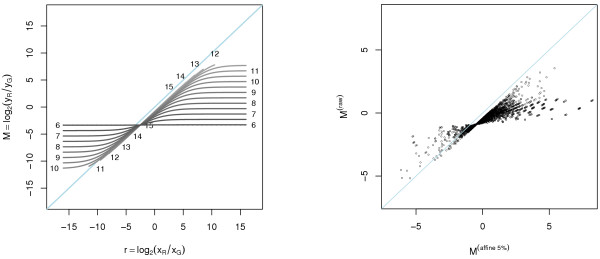
Bias in the log-ratios introduced by the affine transform. Left: Bias in the log-ratios introduced by the affine transform A1
MathType@MTEF@5@5@+=feaafiart1ev1aaatCvAUfeBSjuyZL2yd9gzLbvyNv2CaerbwvMCKfMBHbqedmvETj2BSbWenfgDOvwBHrxAJfwnHbqeg0uy0HwzTfgDPnwy1aqee0evGueE0jxyaibaieYdOi=BH8vipeYdI8qiW7rqqrFfpeea0xe9Lq=Jc9vqaqpepm0xbbG8FasPYRqj0=yi0lXdbba9pGe9qqFf0dXdHuk9fr=xfr=xfrpiWZqaaeaabiGaaiaacaqabeaadaqacqaaaOqaaGWaaiab=bq8bnaaBaaaleaatCvAUfKttLearCWrP9MDH5MBPbIqV92AaGqbaiab+fdaXaqabaaaaa@43C0@. Each line displays the relationship between the observed and the true log-ratios at a certain (observed) log-intensity A. Each curve is marked with the value of A. We have chosen to truncate the curves when the signals become saturated and the labels for those curves are positioned approximately where they have been truncated. For low intensities there is a great bias (deviance from the diagonal line), especially for large fold changes. At higher intensities the bias is smaller. The curves intersect at the one fold-change level that is independent of the intensity. Right: Real-world example of log-ratios for non-normalized versus affine normalized (with 5% negative) signals. The affine parameters are (a^G
MathType@MTEF@5@5@+=feaafiart1ev1aaatCvAUfKttLearuWrP9MDH5MBPbIqV92AaeXatLxBI9gBaebbnrfifHhDYfgasaacH8akY=wiFfYdH8Gipec8Eeeu0xXdbba9frFj0=OqFfea0dXdd9vqai=hGuQ8kuc9pgc9s8qqaq=dirpe0xb9q8qiLsFr0=vr0=vr0dc8meaabaqaciaacaGaaeqabaqabeGadaaakeaacuWGHbqygaqcamaaBaaaleaacqWGhbWraeqaaaaa@2F4A@, a^R
MathType@MTEF@5@5@+=feaafiart1ev1aaatCvAUfKttLearuWrP9MDH5MBPbIqV92AaeXatLxBI9gBaebbnrfifHhDYfgasaacH8akY=wiFfYdH8Gipec8Eeeu0xXdbba9frFj0=OqFfea0dXdd9vqai=hGuQ8kuc9pgc9s8qqaq=dirpe0xb9q8qiLsFr0=vr0=vr0dc8meaabaqaciaacaGaaeqabaqabeGadaaakeaacuWGHbqygaqcamaaBaaaleaacqWGsbGuaeqaaaaa@2F60@, log2β^
MathType@MTEF@5@5@+=feaafiart1ev1aaatCvAUfKttLearuWrP9MDH5MBPbIqV92AaeXatLxBI9gBaebbnrfifHhDYfgasaacH8akY=wiFfYdH8Gipec8Eeeu0xXdbba9frFj0=OqFfea0dXdd9vqai=hGuQ8kuc9pgc9s8qqaq=dirpe0xb9q8qiLsFr0=vr0=vr0dc8meaabaqaciaacaGaaeqabaqabeGadaaakeaaiiGacuWFYoGygaqcaaaa@2E64@) = (45.7, 27.0, -0.418). To clarify the intensity-dependent effect only data points close to A = 0.0, 0.5,...,16 are shown.